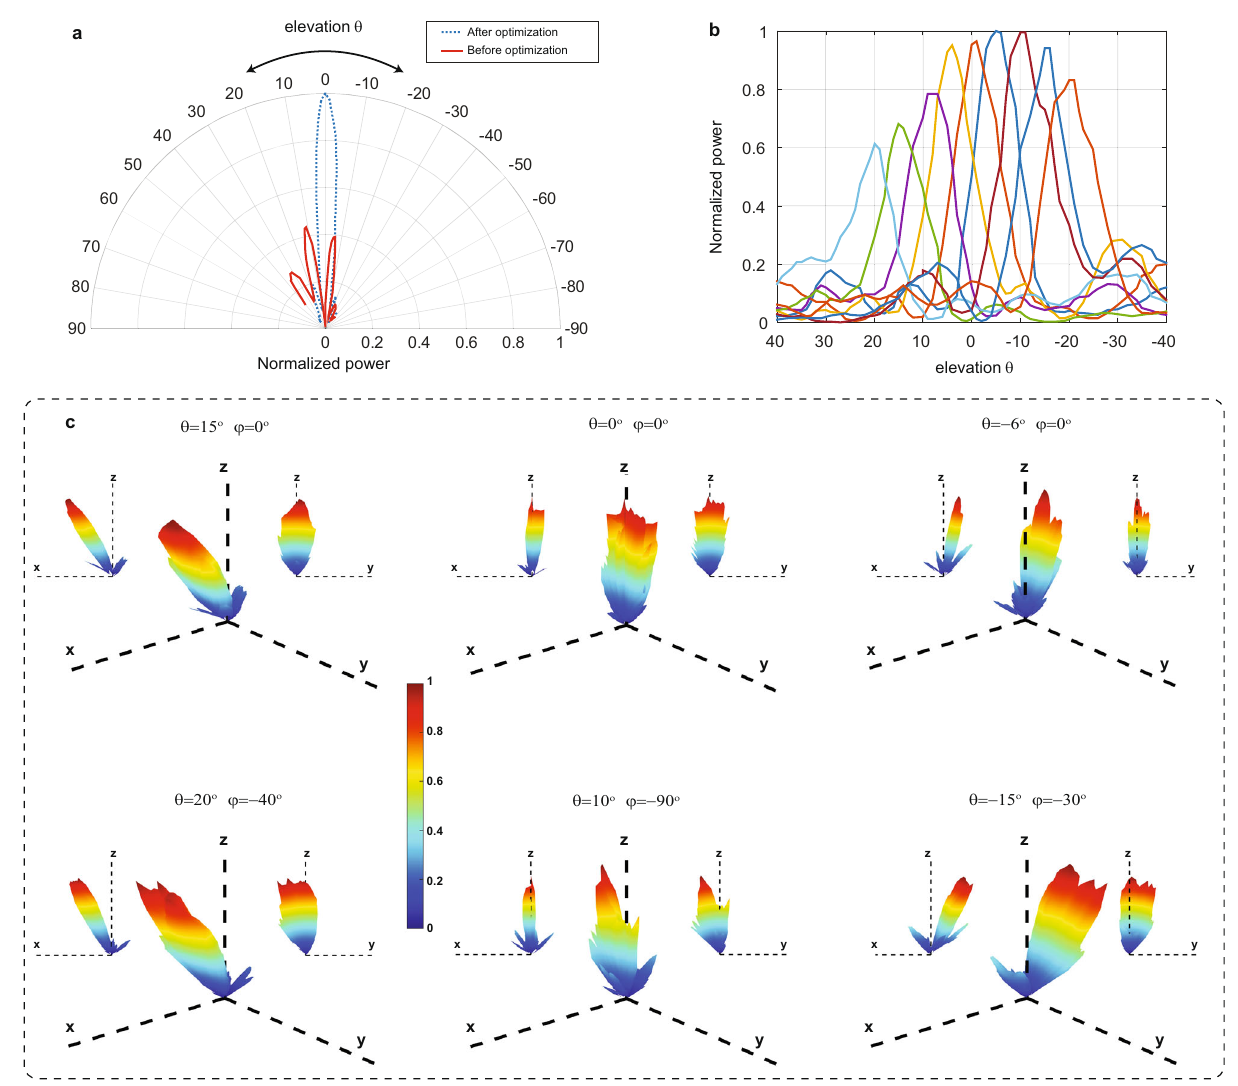
f =25.5GHz). c 3D radiation pattern with the phased array con fi gured to point at various